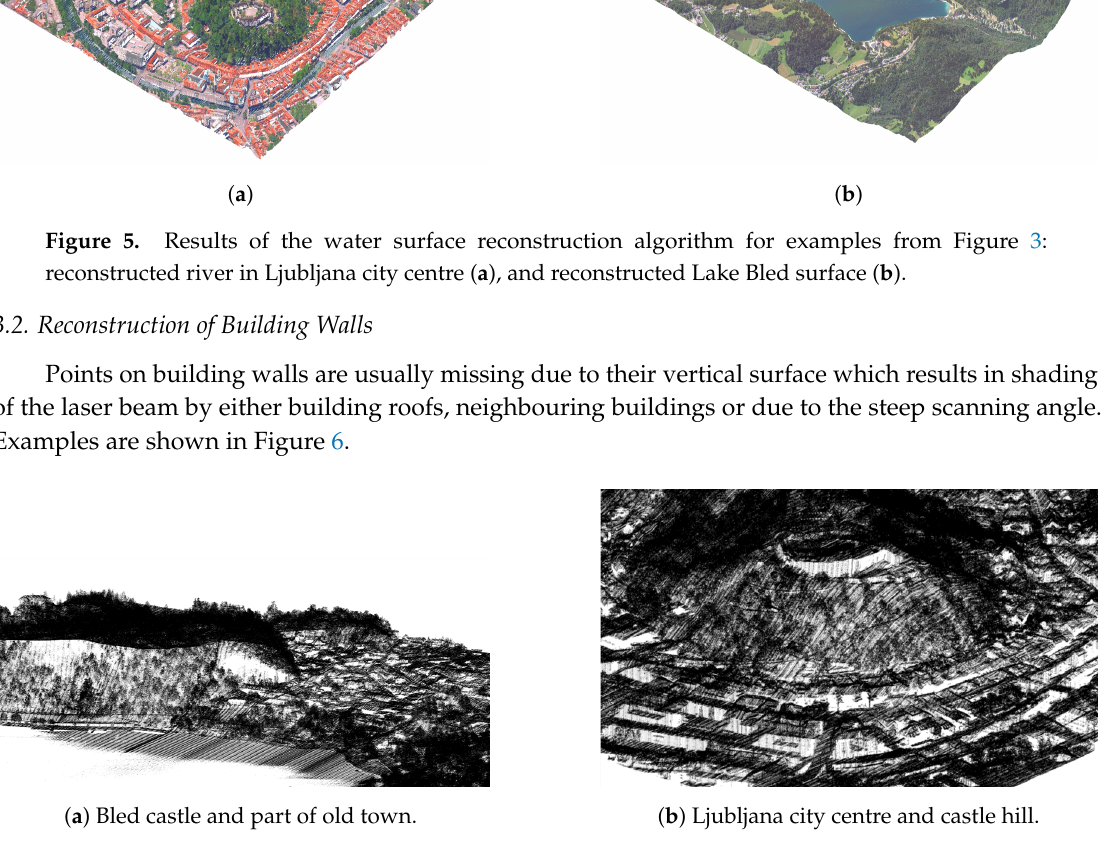
Figure 6. Examples of missing points in building walls, where white regions within the point-cloud indicate the missing points mostly of building walls, but also of terrain